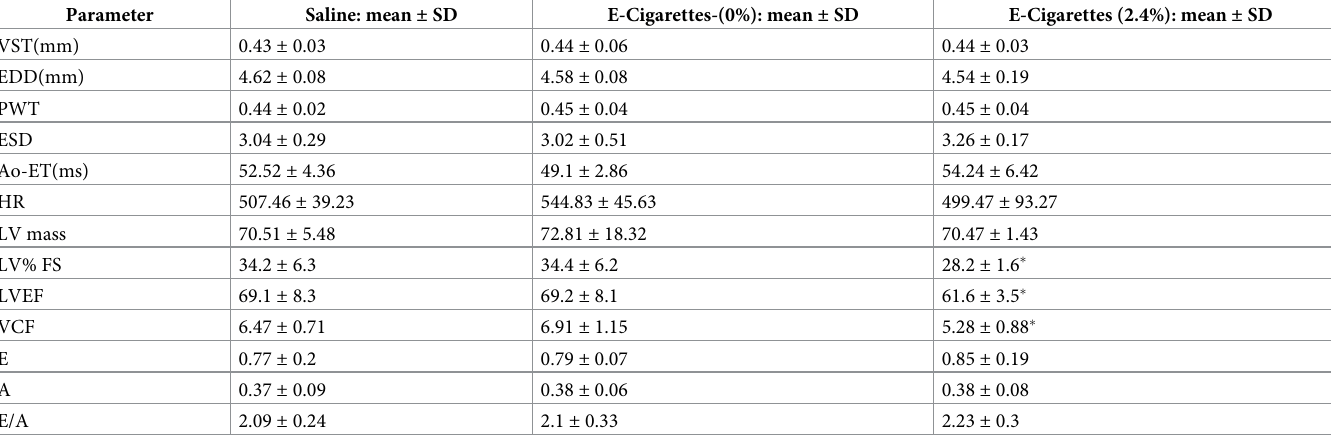
Abbreviations: VST, ventricular septal thickness; PWT, posterior wall thickness; EDD, end-diastolic dimension; ESD, end systolic dimension; AoEt, aortic ejection time; HR, heart rate; LV%FS, left ventricle fractional shortening; VCF, velocity of circumferential fiber shortening; LVEF, left ventricle ejection fraction; LV Mass, left ventricle mass; E, early diastole (LV filling); A, atrial systole: H/B ratio, Heart/body ratio. � P < 0.05 (n =